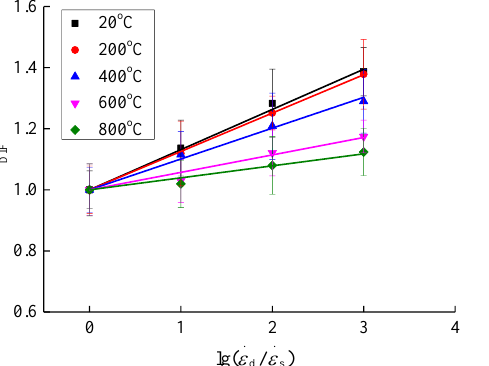
Figure 11. Relationship between strain rate and concrete dynamic increase coefficient. According to Figure 10, when the temperature is 20 ◦ C, the compressive stress is increased from 35.69 MPa at the static strain rate of 10 − 5 /s to 49.50 MPa at the strain rate of 10 − 2 /s, indicating an increase by 38.69% due to the strain rate. When the temperature is 200 ◦ C, the compressive stress is increased from 33.58 MPa at the static strain rate of 10 − 5 /s to 46.29 MPa at the strain rate of 10 − 2 /s, indicating an increase by 37.85% due to the strain rate. When the temperature is 400 ◦ C, the compressive stress is increased from 27.96 MPa at the static strain rate of 10 − 5 /s to 36.07 MPa at the strain rate of 10 − 2 /s, indicating an increase by 29.01% due to the strain rate. When the temperature is 600 ◦ C, the compressive stress is increased from 17.94 MPa at the static strain rate of 10 − 5 /s to 21.07 MPa at the strain rate of 10 − 2 /s, indicating an increase by 17.45% due to the strain rate. When the temperature is 800 °C, the compressive stress is increased from 9.77 MPa at the static strain rate of 10 − 5 /s to 10.98 MPa at the strain rate of 10 − 2 /s, indicating an increase by 7.78% due to the strain